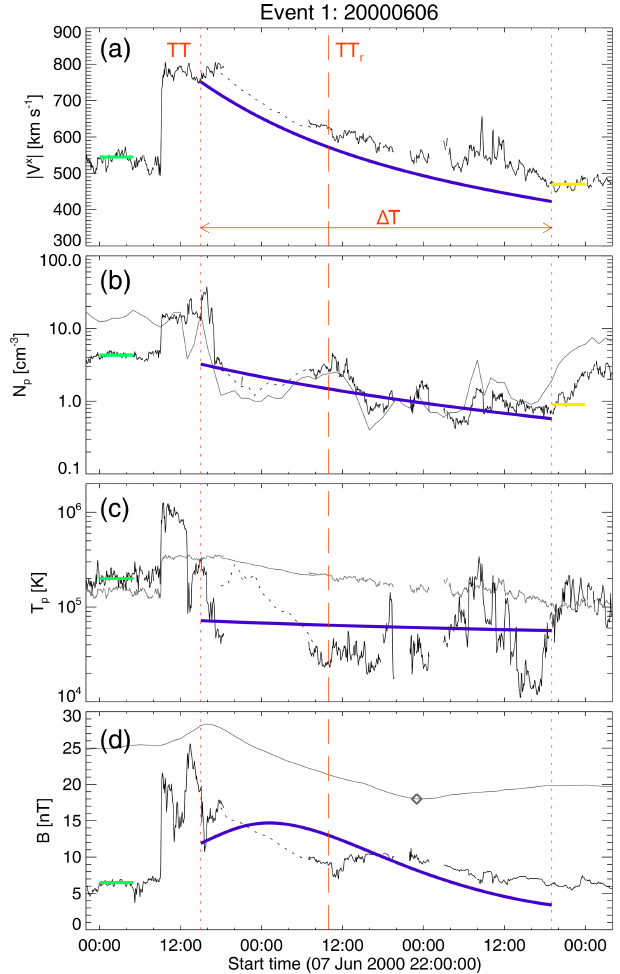
Figure 2. Calculated synthetic transit of Event 1. From top to bot- tom, panels (a) , (b) , (c) , and (d) present the radial component of the solar wind speed ( | V x | ), the density ( N p ) and temperature ( T p ) of protons and the magnetic field intensity ( B ), respectively. Solid blue lines show our model results and the solid (dotted) black lines are 5min (1h) resolution in situ measurements as extracted from NASA/GSFC’s OMNI data set through the OMNIWeb ser- vice. Short-dashed and long-dashed vertical red lines mark the CME boundaries and center, respectively. Solid grey lines in N p and T p panels are the plasma- β (10 folded) and the expected proton temper- ature ( T exp ) (Lopez, 1987; Richardson and Cane, 1993, 1995), re- spectively. Solid grey line in (d) is the accumulative magnetic flux, as defined by Dasso et al. (2006), whose extremum (open diamond) gives an estimation for the magnetic center inside the CME. The green solid lines, on the left-hand side of all panels, mark the in situ solar wind values used as inputs for our calculations; and solid yel- low lines, in the | V x | and N p panels, mark speed and proton density values of the solar wind behind the CME (see Table